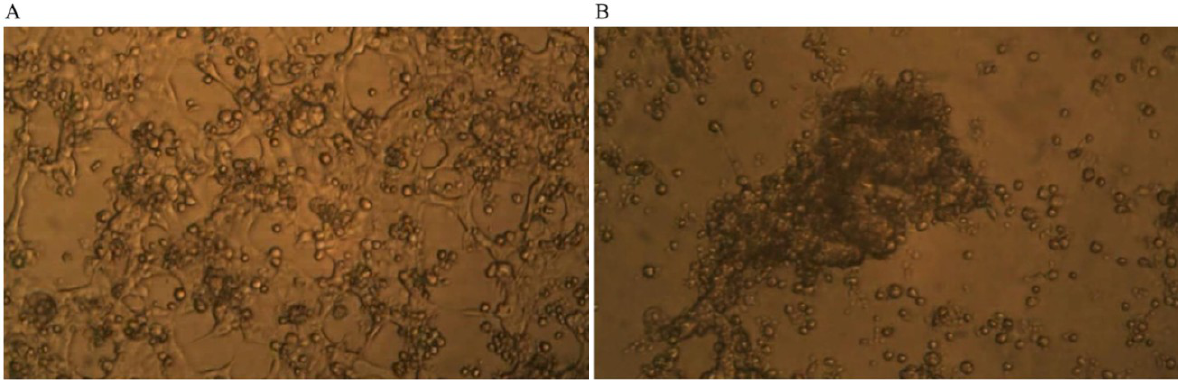
Figure 3. Phase contrast microphotography from time-lapse recording of co-culture of GcMAF-activated macrophages and human breast cancer cells. ( A ) Day one of co-culture; the cancer cells form an irregular layer. Individual cancer cells can be